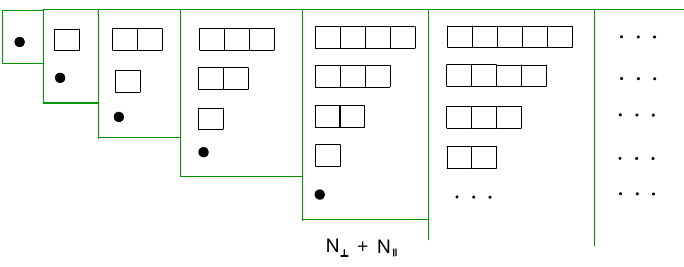
Figure 7 . The so (1 ; 1)-covariant basis of hs [ (cid:21) ] in the canonical form. Each Young diagram of length k stands for an irreducible so (1 ; 1)-module d k . The so (2 ; 1)-modules contours. The counting operator N = N ? + N given